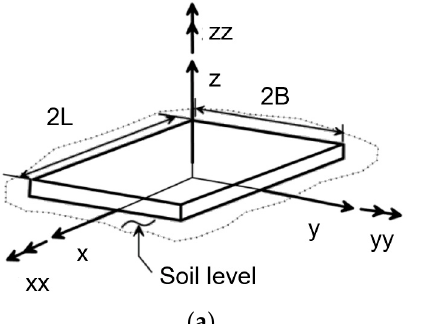
Figure 3. Foundation geometry: axonometry ( a ) and cross-section ( b ) [63] (edited by the authors).